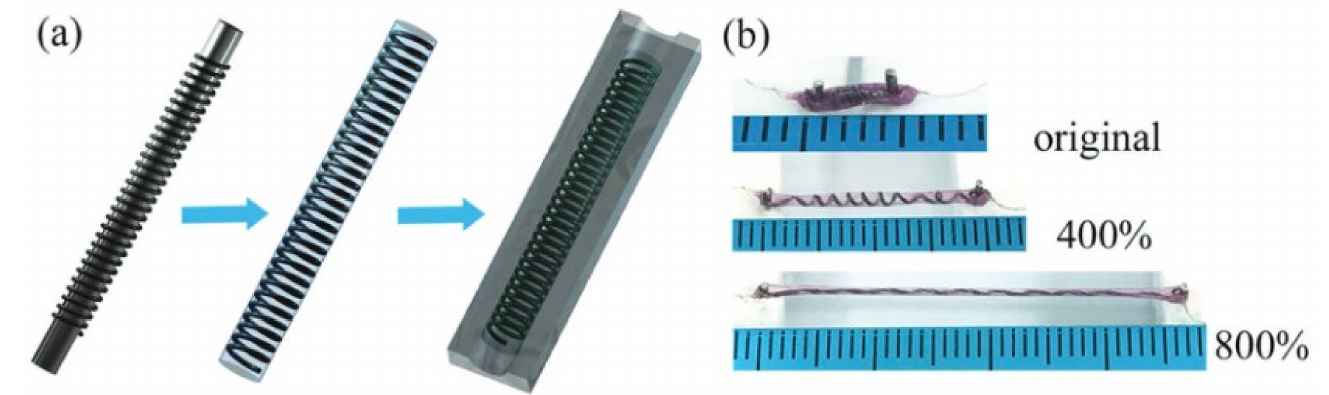
Figure 16. ( a ) Schematic illustration of the fabrication of an FSC in which the yarn is coiled on a rod and cast using SEBS polymer to fix the coil structure. The rod is removed, and the device is placed in a mold to cover the coil yarn with rubber. ( b ) Illustration of the prepared supercapacitor with different strain rates up to 800%. Reprinted with permission from